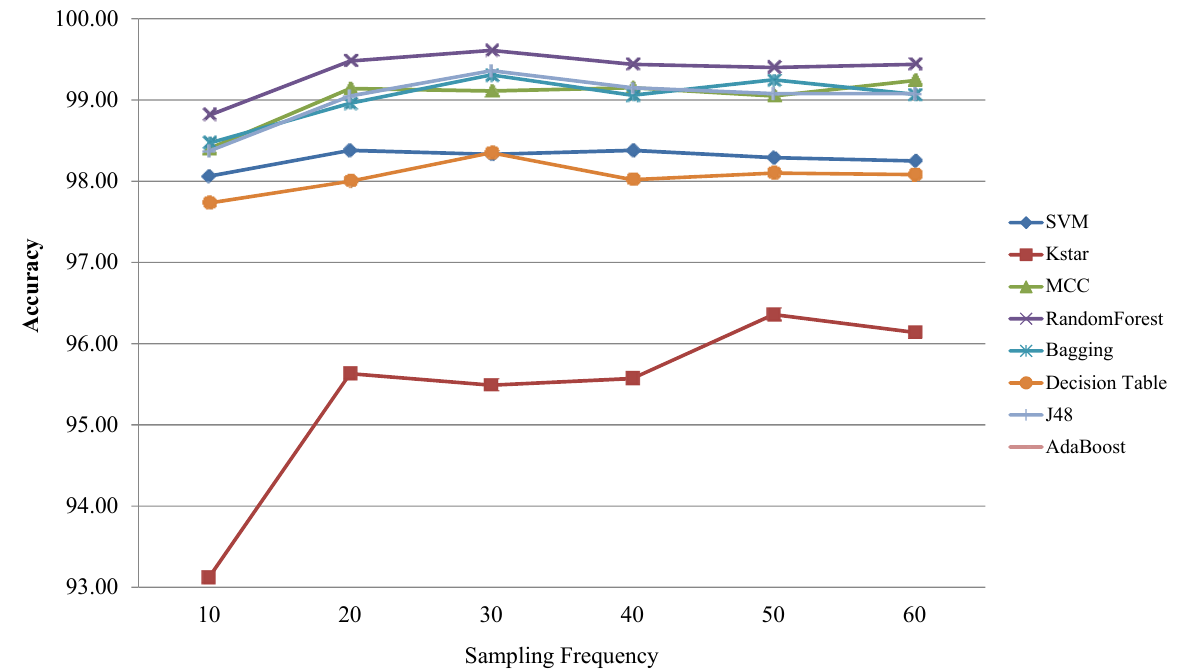
Figure 4. The lowest classification accuracies from AdaBoost and ZeroR were 65.97 (at the 10 Hz sampling frequency) and 38.93 (at the 30 Hz sampling frequency), respectively. Figure 4. Sampling frequency vs . classification